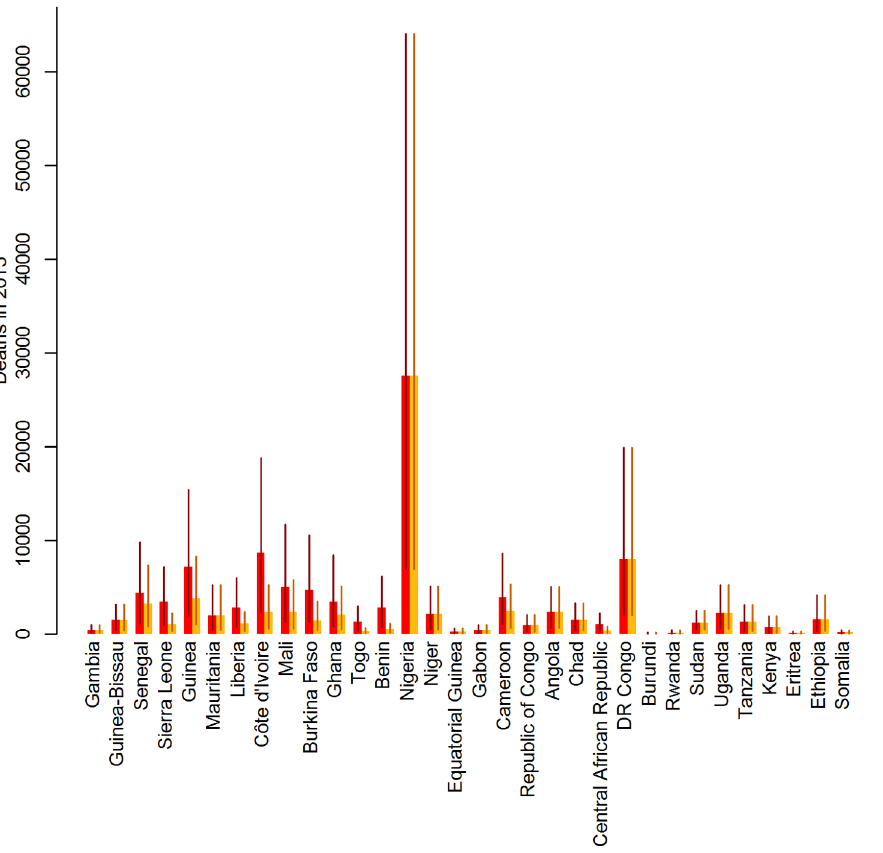
Figure 3. Impact of preventive mass vaccination campaigns between 2006 and 2012 on the estimated number of deaths due to yellow fever in 2013 by country. Red bars show the number of deaths estimated assuming implementation of no mass vaccination campaigns between 2006 and 2012, orange bars show the number of deaths estimated for the actual vaccination. Lines show the 95% credibility intervals of the estimated number of deaths. Countries are ordered west to east.